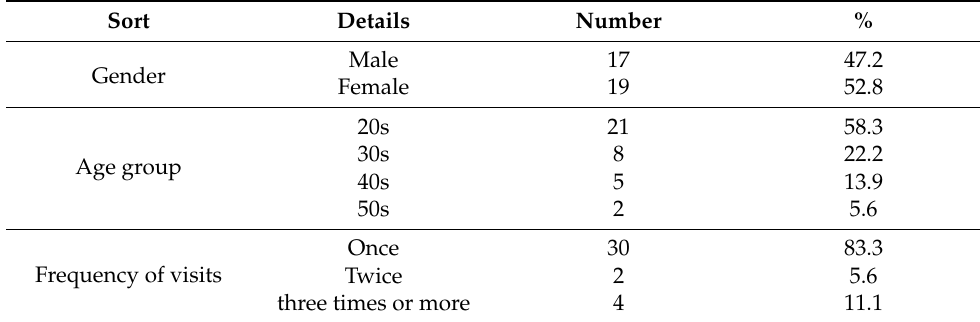
Table 5. Information of the evaluation